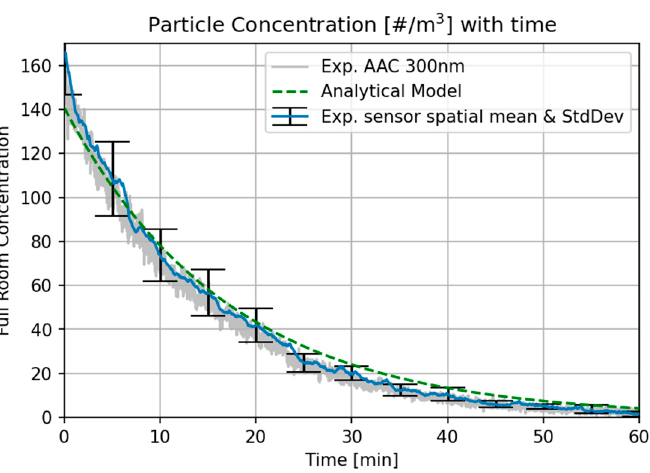
Figure 6. Room averaged concentration measured as number of particles per cubic centimeter [#/m 3 ] compared to an analytical model.